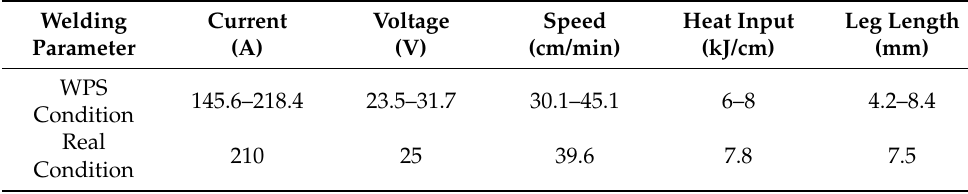
Table 3. Heat input parameter for making the fillet weld length.